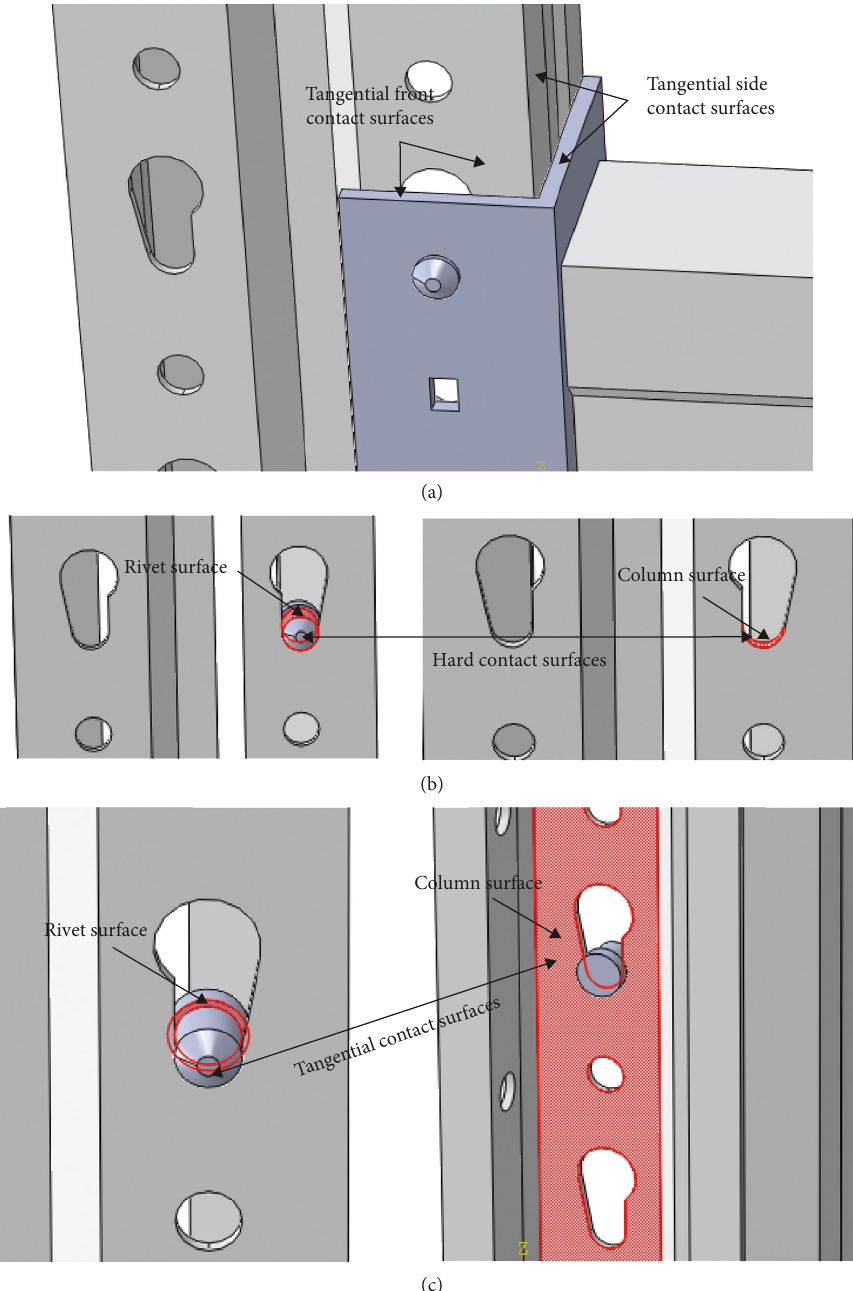
Figure 5: Surface-to-surface interaction among components. (a) Interactions between column and the beam-end connector. (b) Normal hard contact between column and rivets. (c) Tangential frictionless contact between column and